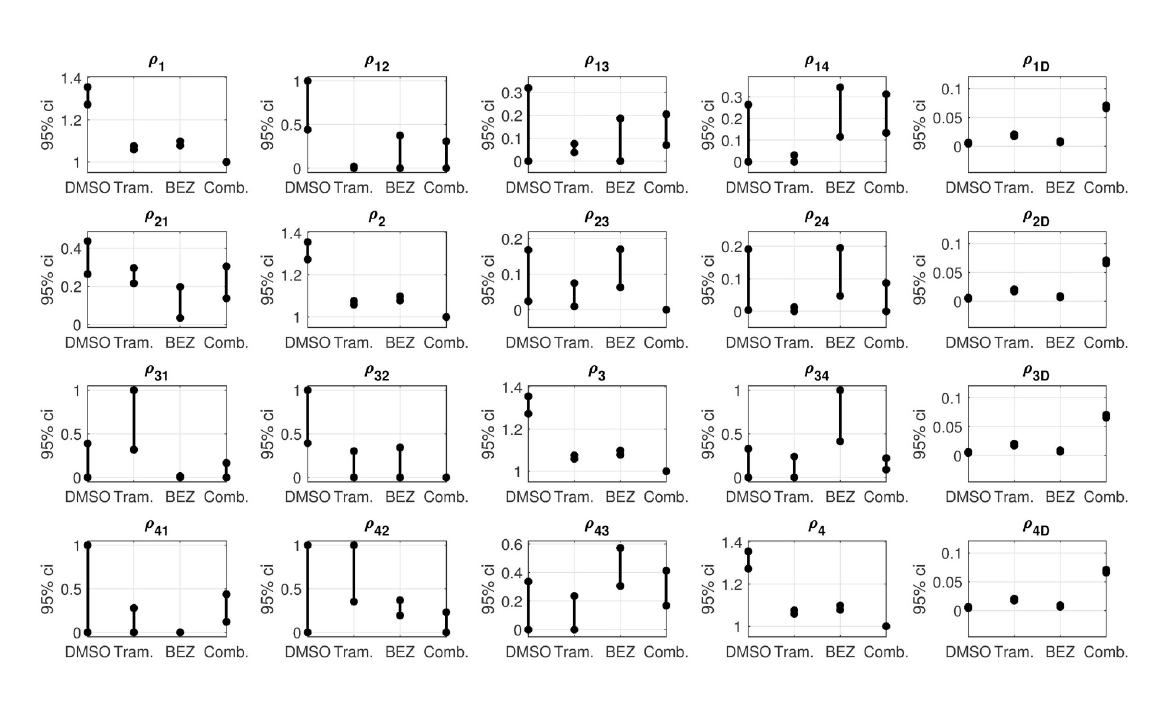
Fig 4. Uncertainty analysis of the dynamics parameters. For each treatment condition, 95% confidence intervals computed from the model ensemble are shown. These intervals indicate variations of the dynamics parameters due to measurement noise. Non-overlapping intervals of a given parameter specify a statistically significant difference. For example, a statistically significant reduction in K14 hi -to-VIM hi K14 low transition was detected under Trametinib versus DMSO because the ρ 12 -interval for Trametinib is strictly below the ρ 12 -interval for DMSO. A p-value for each dynamics parameter is also provided in S2